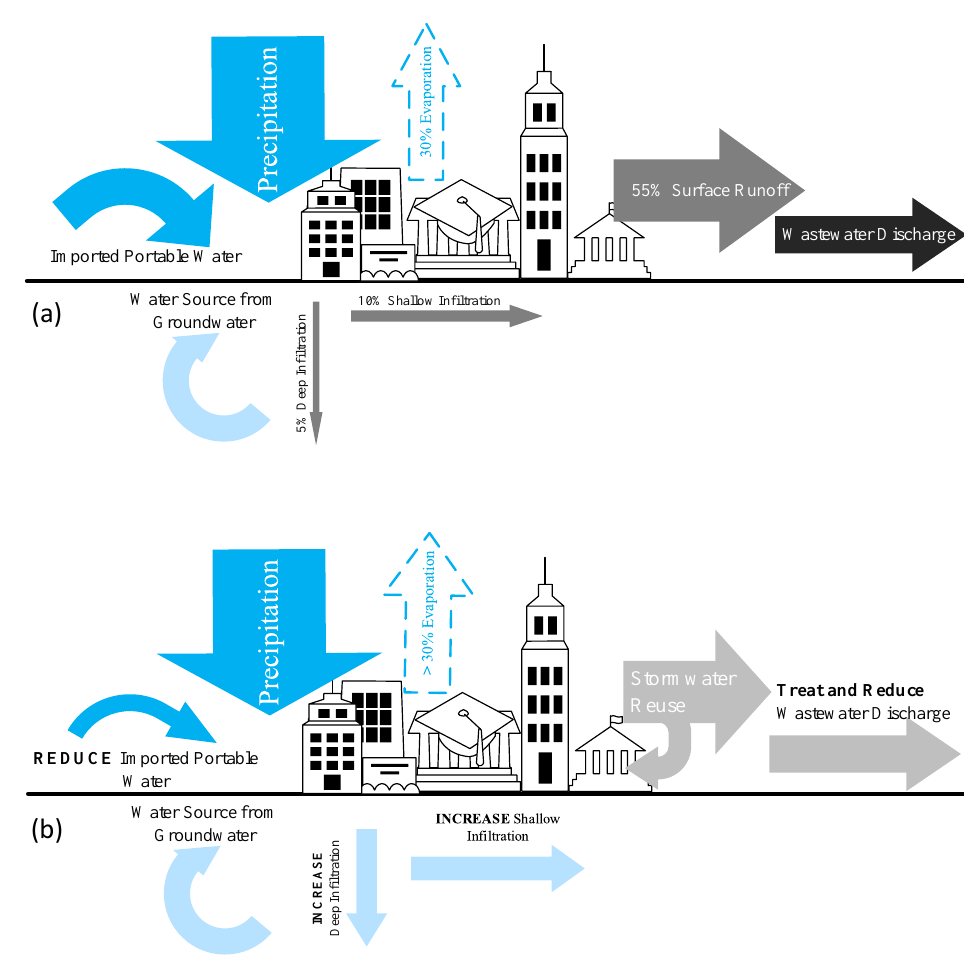
Figure 3. Water flow direction and percentage in ( a ) urbanized area with large water demand; ( b ) urbanized area with reduced water demands on a neighborhood basis.